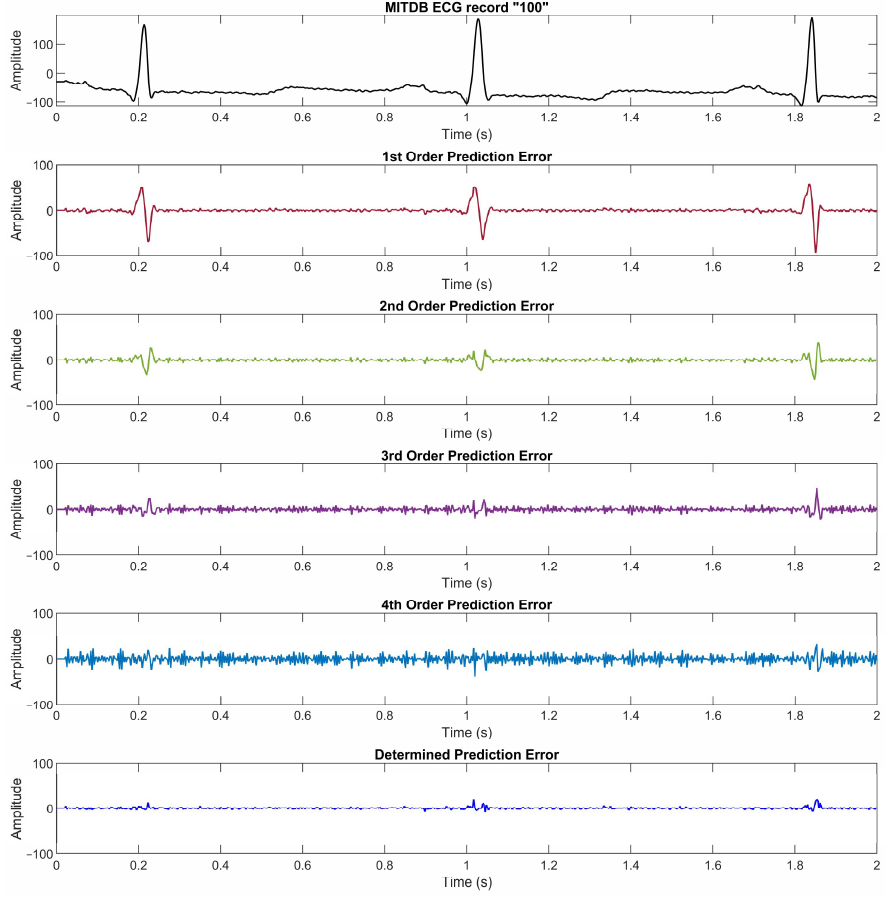
Figure 3. The ECG signal, prediction errors for linear prediction orders 1, 2, 3, and 4, and the determined prediction error of MITDB record number “100”. To convert the amplitude to millivolts, divide the value by 200.